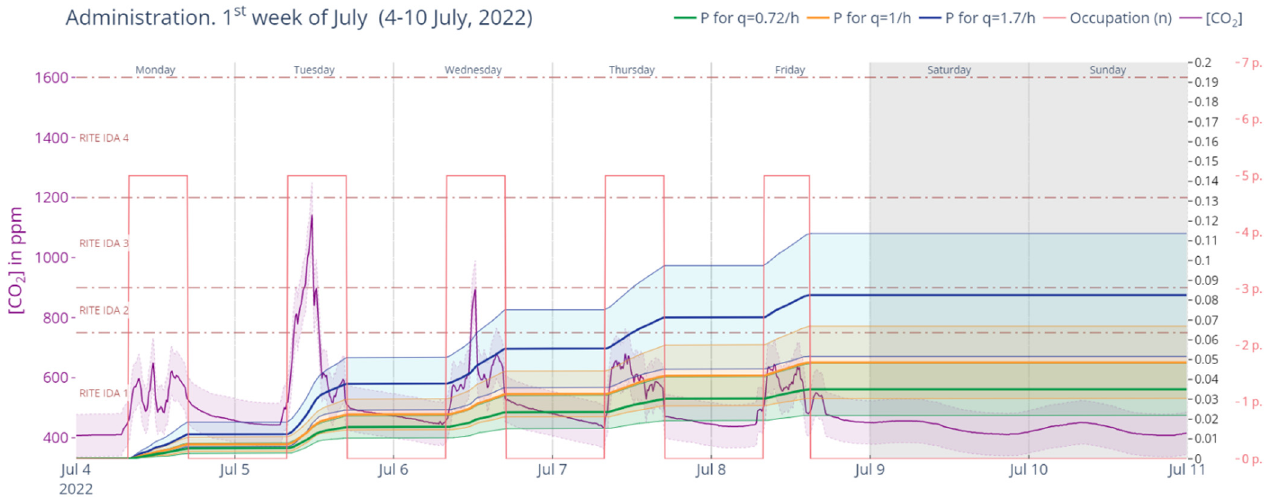
Figure 26. Retrospective analysis of secondary infection risk during the first week of July, 2022 (Phase III). Source: authors.